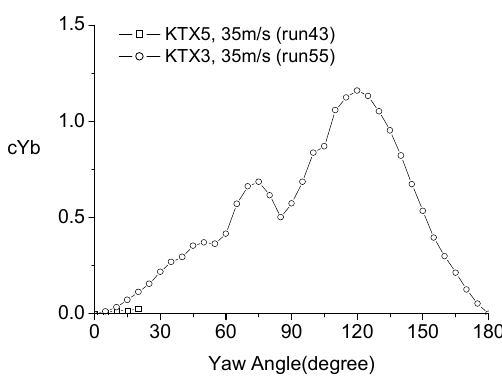
Figure 5 Side force coefficient (KTX T5-car) Figure 6 and Figure 7 show the side force coefficients of 2nd car(T2) and 4th car(T4), respectively. T2 and T4 are also identical in shape that the side force coefficient is all the same for 3-car and 5-car configuration except for the adverse x-axis, the yaw angle. T4 is also affected with the upstream-located vehicles at low yaw angle, however, the difference of side force coefficient between 3-car and 5-car model is smaller than the difference in case of T5, because T4 car has less upstream-located vehicles than T5 car. The maximum side force coefficients of T2 and T4 are 0.62 at 130 and 50 degree yaw angle, respectively.